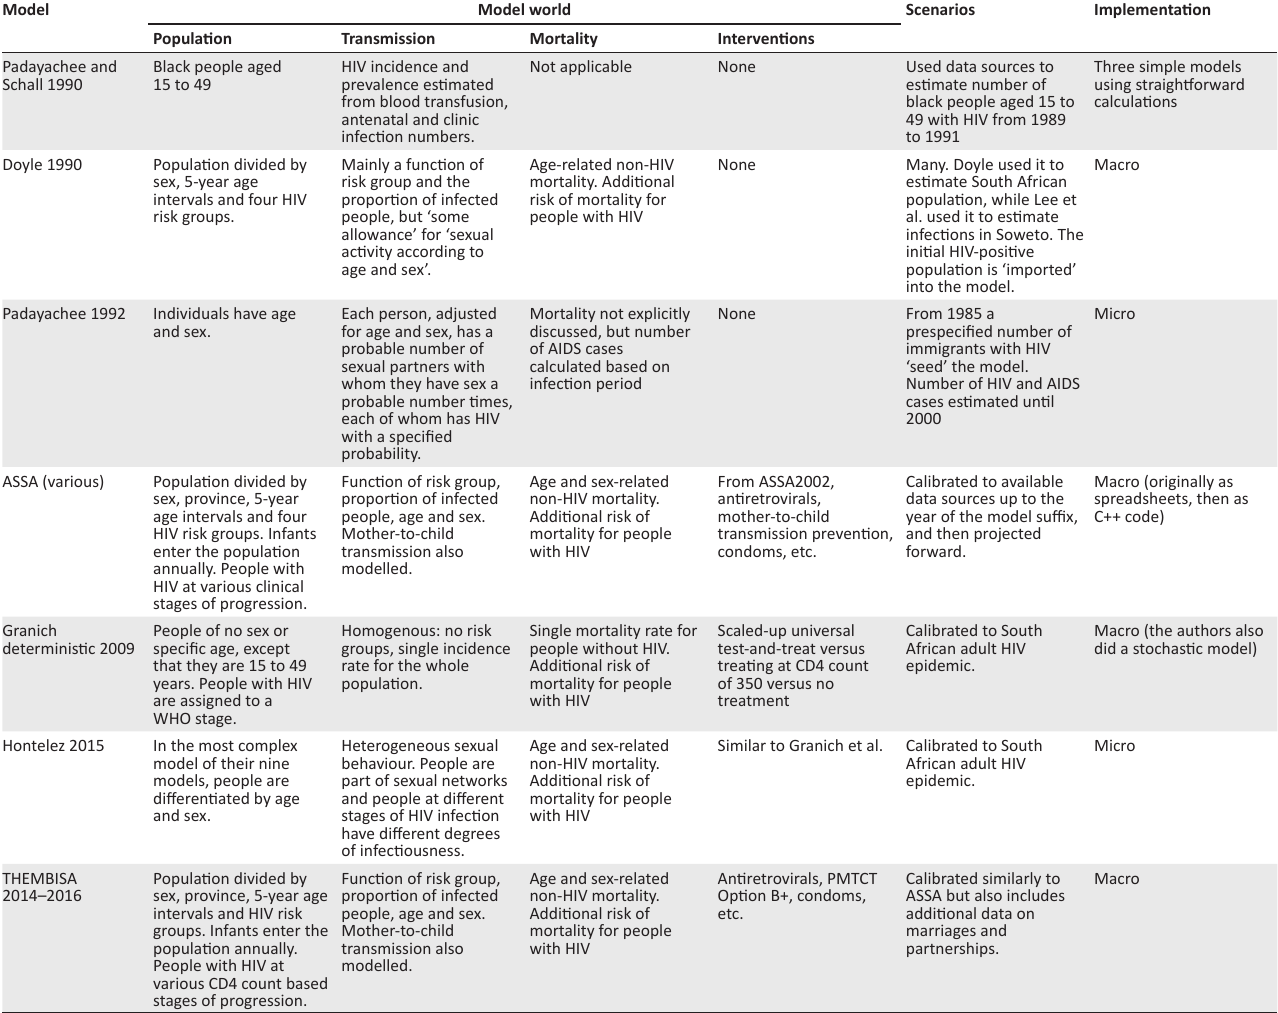
TABLE 1: Examples of models of the South African HIV epidemic.